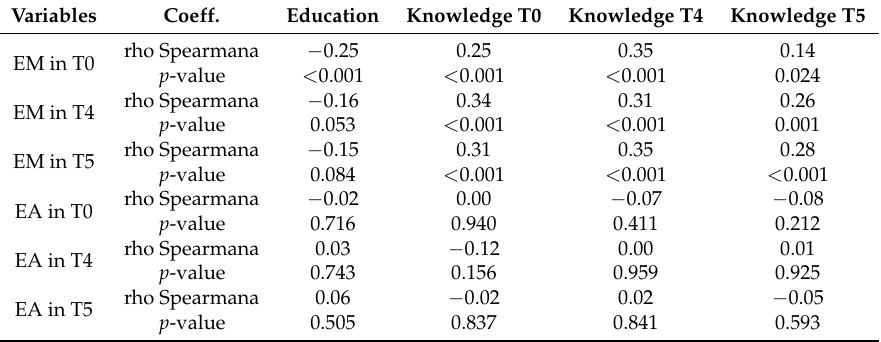
Table 6. Correlation analysis coefficients for relationships between energy monitoring (EM), attitude towards environmental issues (EA), Education, and Knowledge in T0, T4, T5, and weekly attitude. Variables Coeff. Education Knowledge T0 Knowledge T4 rho Spearmana −